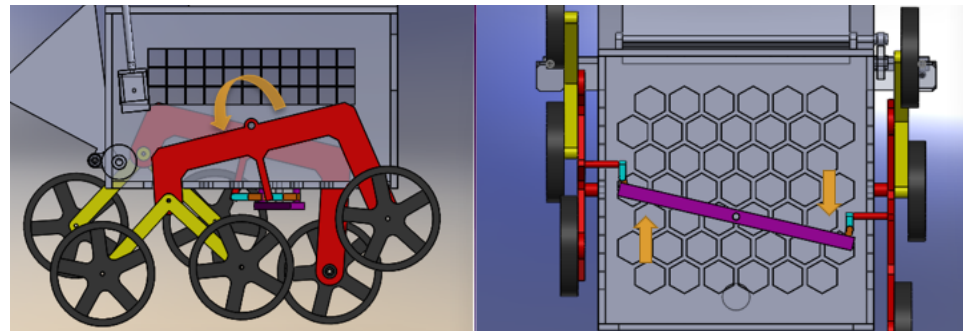
Figure 3. Rocker movements ( left ) and differential shaft ( right